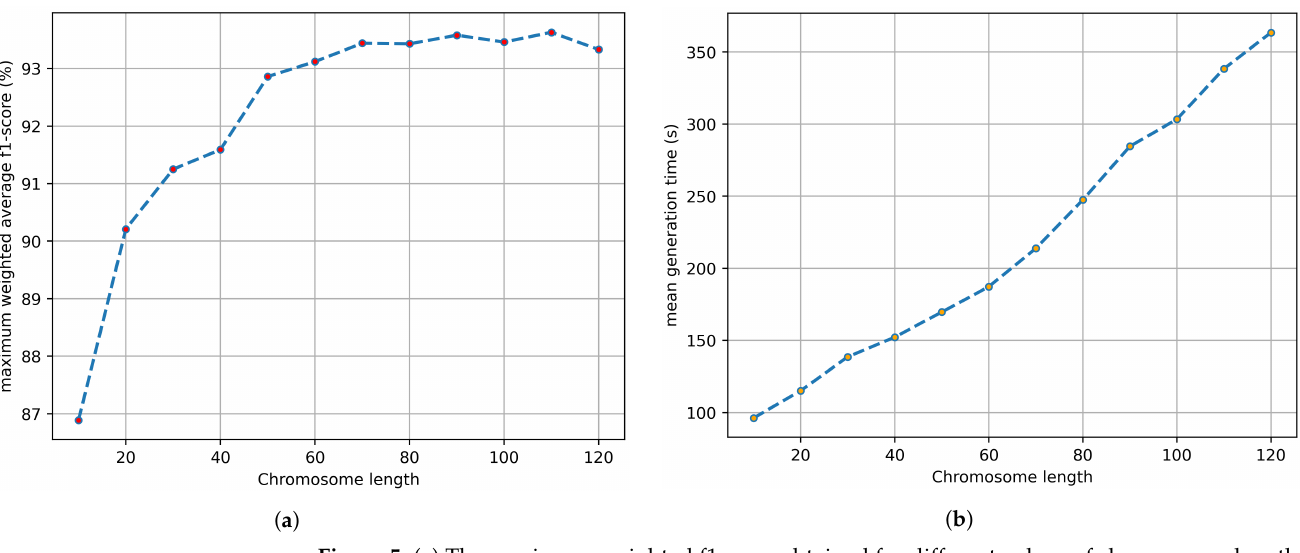
Figure 5. ( a ) The maximum weighted f1 score obtained for different values of chromosome length. ( b ) The mean generation time required for different values of chromosome